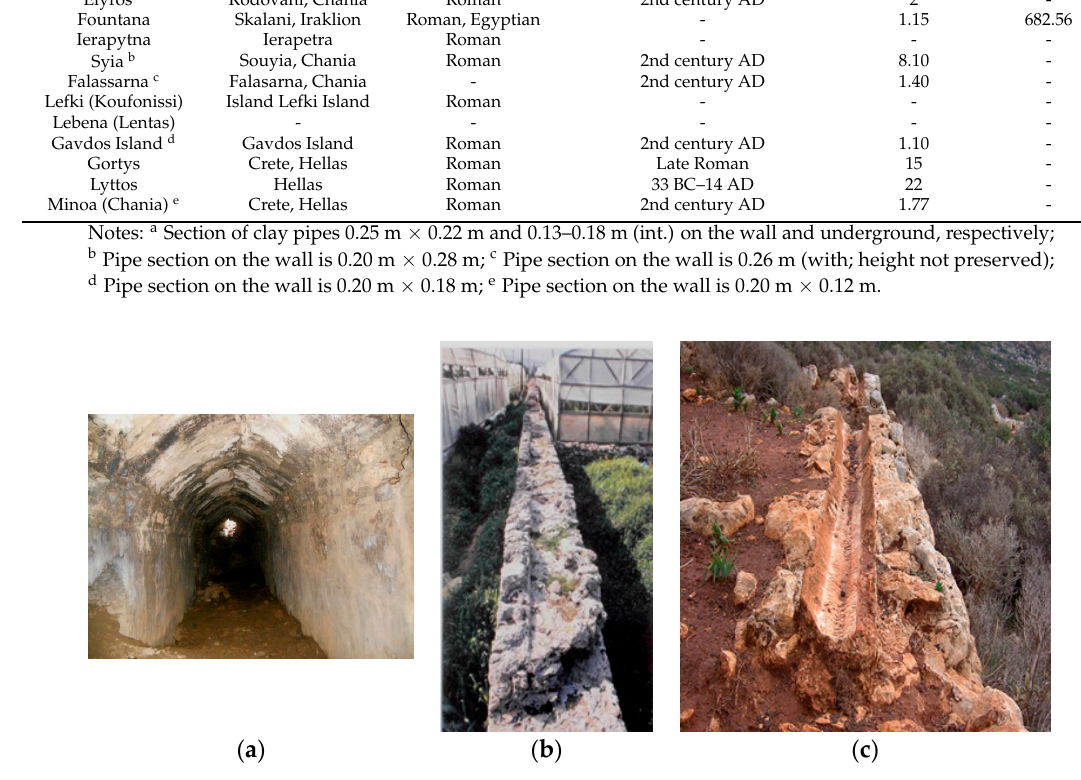
Figure 4. Parts of Roman aqueducts: ( a ) cistern in Elyros; ( b ) conduit in Falassarna; and ( c ) conduit in Minoa (Marathi) (with permission of J. Christodoulakos).